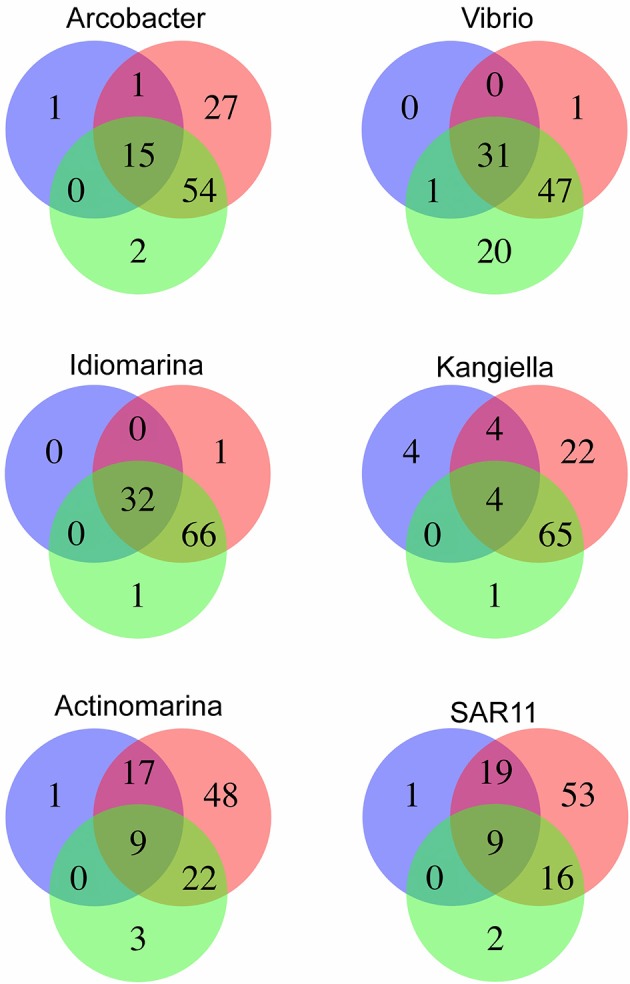
Functional diversity in the traps on KEGG KO level as percentage of total KO diversity for the genus, as predicted by the SAGs (blue), the closest reference genome (red) and the genus specific metagenome from the same HD9 trap as the SAGs were isolated from (green). When combined with the closest reference all SAGs except Vibrio predict the majority of the diversity in the trap, which indicate that the SAG is representative for the functional diversity in the trap. The genus Vibrionales display a substantial functional diversity not predicted by the SAG or closest reference.